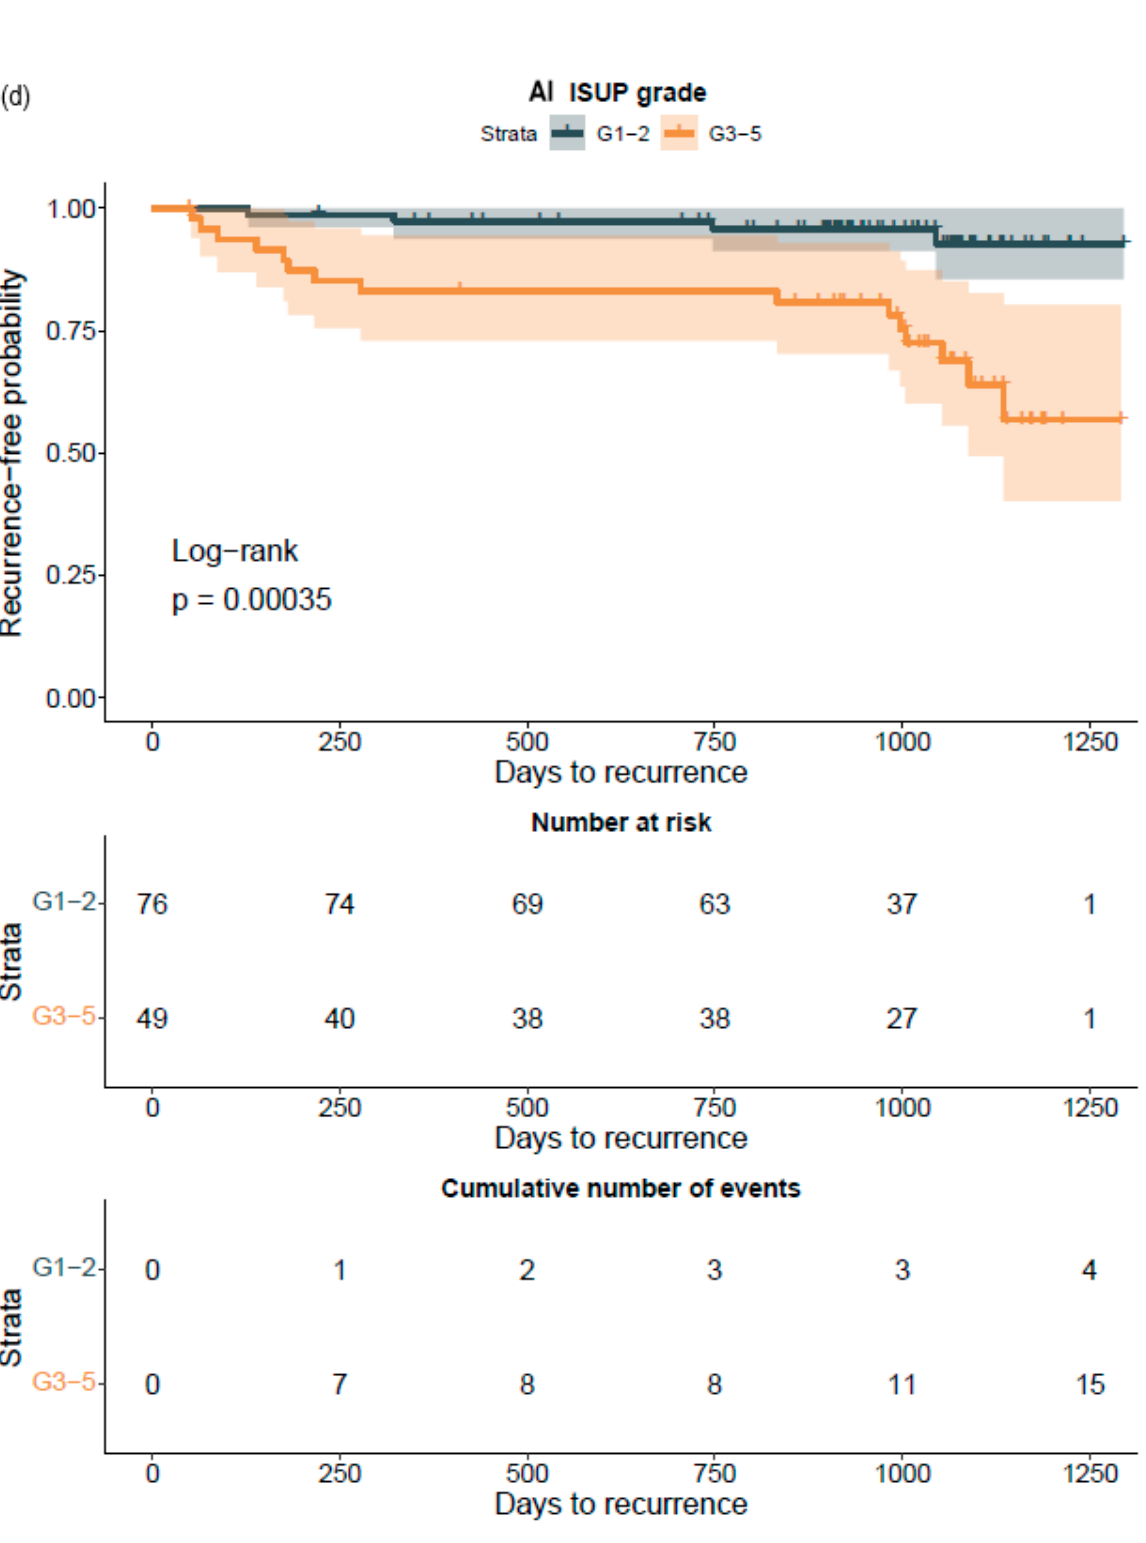
Figure 7. Kaplan–Meier survival analysis for biochemical recurrence on non-stratified ( a , b ) and stratified (1–2 versus 3–5) ( c , d ) cancer-positive biopsies for the prostatectomy cohort. The graph shows 95% confidence intervals.